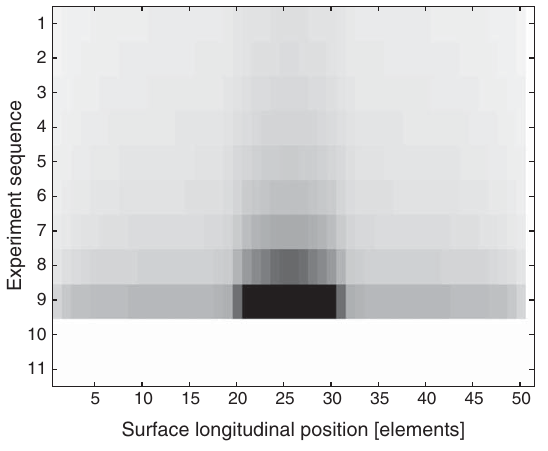
For each experiment are reported the correct answers (ca), meaning that the subject recognized that the two stiffnesses were different, and the non-correct answers (non-ca), meaning that the subject did not recognized the two stiffnesses as different. For each set of data is reported the percentage of correct answers (pca).